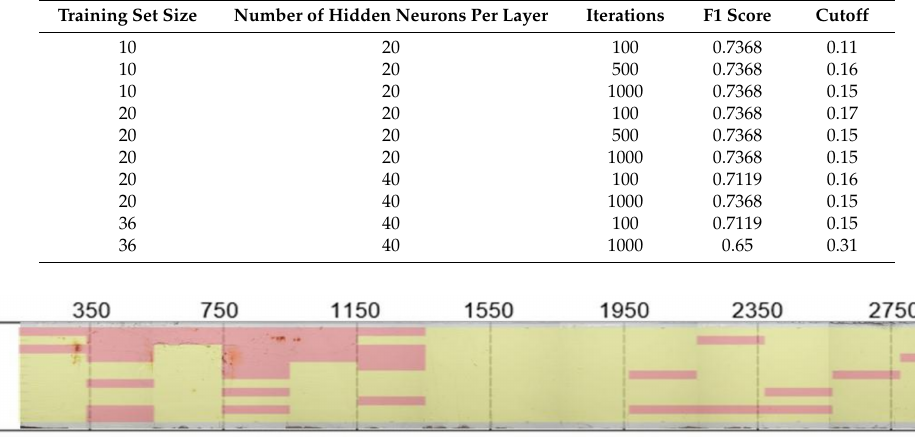
Figure 12. Damage detection with only EIF and automated cutoff value.